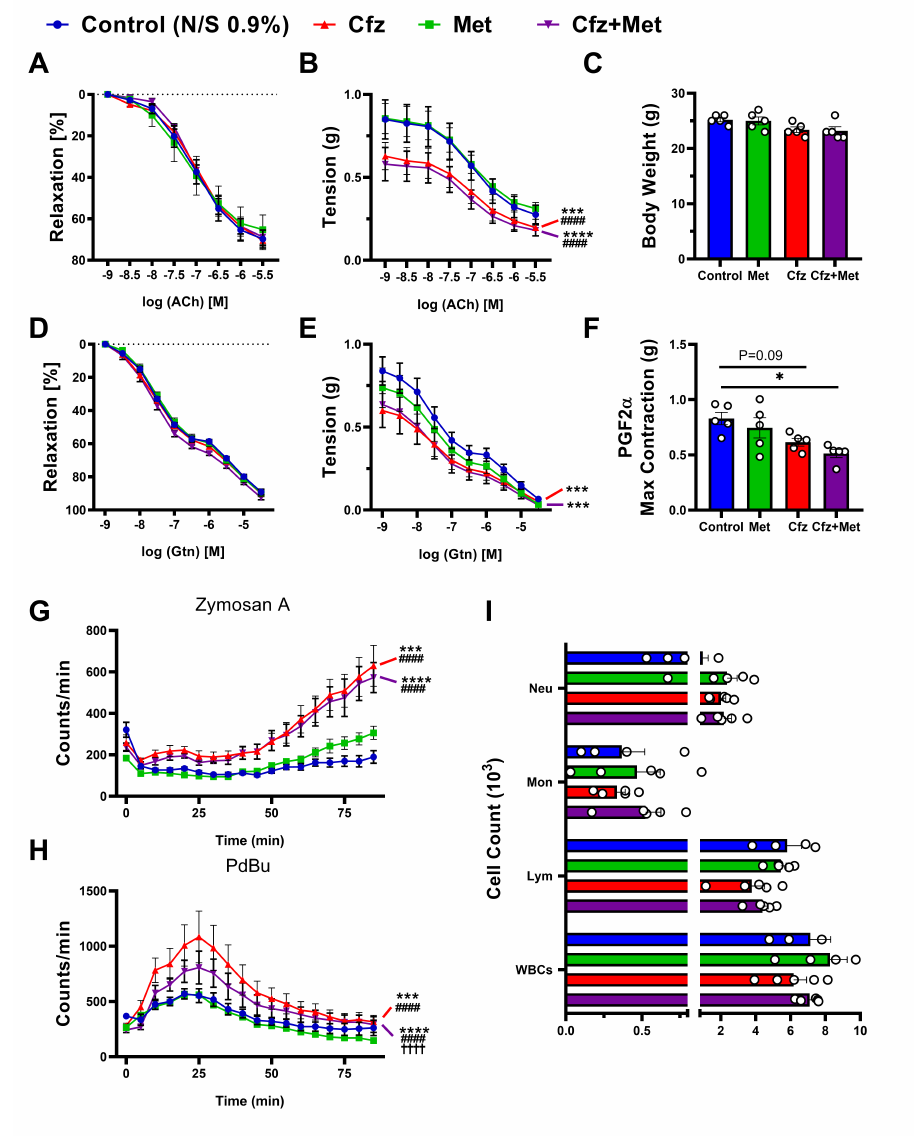
Figure 1. Carfilzomib leads to an acute hypo-contractile phenotype in murine vessels and a significant increase in leucocyte-derived reactive oxygen species (ROS) release, independently of metformin coadministration. Relaxation curves of ( A ) % relaxation to acetylcholine (ACh; n = 5 per group), ( B ) tension (g) following ACh-relaxation (*** p < 0.005 vs. control; #### p < 0.001 vs. Met; two way ANOVA, Tukey’s multiple comparison test, main column e ff ect; n = 5 per group) and ( C ) graph of body weight (g; n = 5 per group). Relaxation curves of ( D ) % relaxation to nitroglycerine (Gtn) (n = 5 per group), ( E ) tension (g) following Gtn-relaxation (*** p < 0.005 vs. control; two way ANOVA, Tukey’s multiple comparison test, main column e ff ect; n = 5 per group) and ( F ) PGF2 α maximal contraction (g; * p < 0.05, one way ANOVA, Tukey’s multiple comparison test; n = 5 per group). Curves of ( G ) Zymosan A and ( H ) PdBu oxidative burst (counts / min) in course of time (min; *** p < 0.005 vs. control; #### p < 0.001 vs. Met; †††† p < 0.001 vs. Cfz; two way ANOVA, Tukey’s multiple comparison test, main column e ff ect; n = 5 per group). ( I ) Graphs of circulating cell count ( × 10 3 ) in whole blood samples. Data are presented as mean ± SEM and individual values are presented as scatter column graphs. Blue lines / columns represent the control (Normal Saline; NS 0.9%), red lines / columns represent Cfz (8 mg / kg, ip), green lines / columns Met (140 mg / kg, per os) and purple lines / columns Cfz + Met (8 mg / kg, ip and 140 mg / kg, per os, respectively) in the 2 days protocol (acute protocol). Cfz, carfilzomib; Met, metformin; Neu, Neutrophils; Mon, Monocytes; Lym, Lymphocytes; WBCs, White Blood